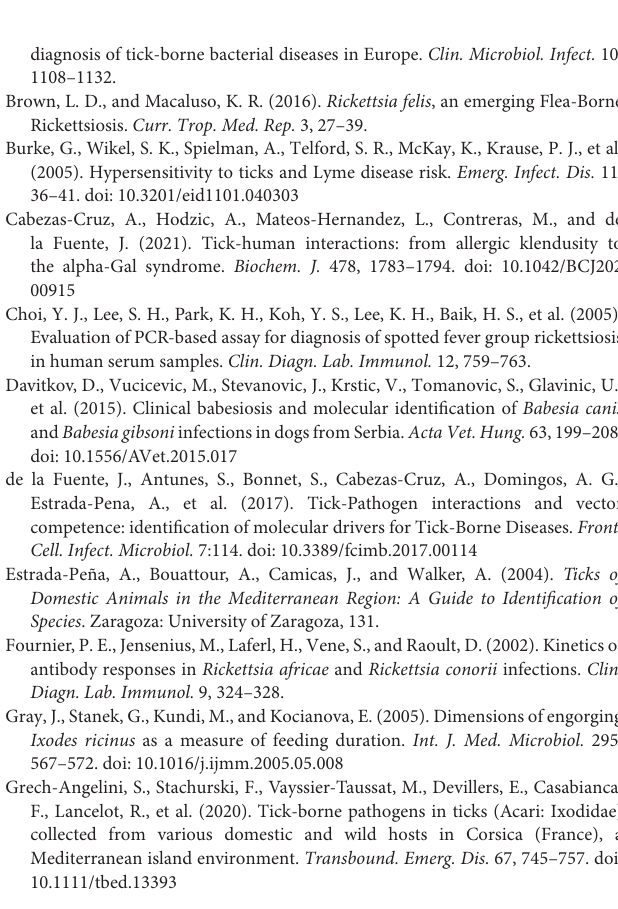
Supplementary Figure 1 | Dorsal (on left) and ventral (on right) views of the two engorged Ixodes ricinus female ticks collected from the cat. Supplementary Table 1 | Information about the geographic distribution and age of enrolled patients and ticks collected from the patients, including tick species, developmental stage, tick attachment time, and information on the integrity of the tick specimen after